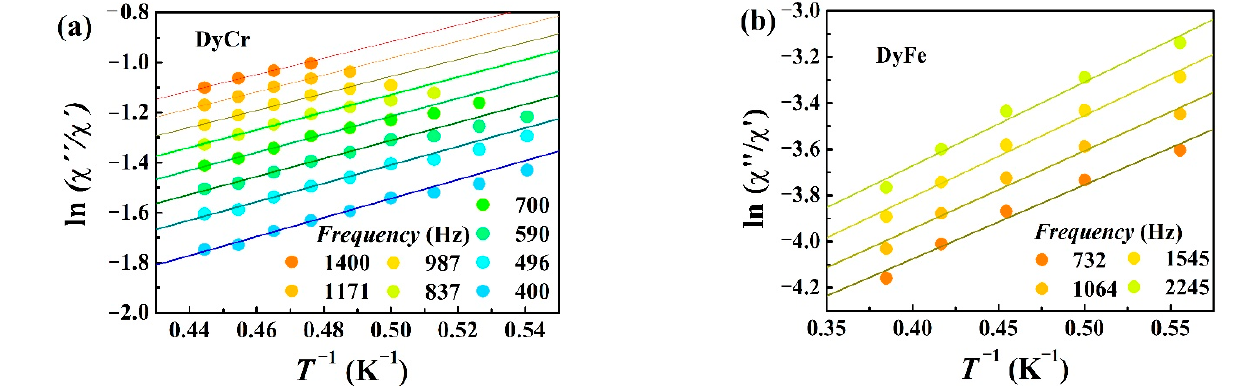
Figure 7. ln( χ′′ / χ′ ) vs. 1/ T plots for 1 ( a ) and 2 ( b ) at different frequencies of ac field. The solid color lines are the approximations by Equation (1) (see text).